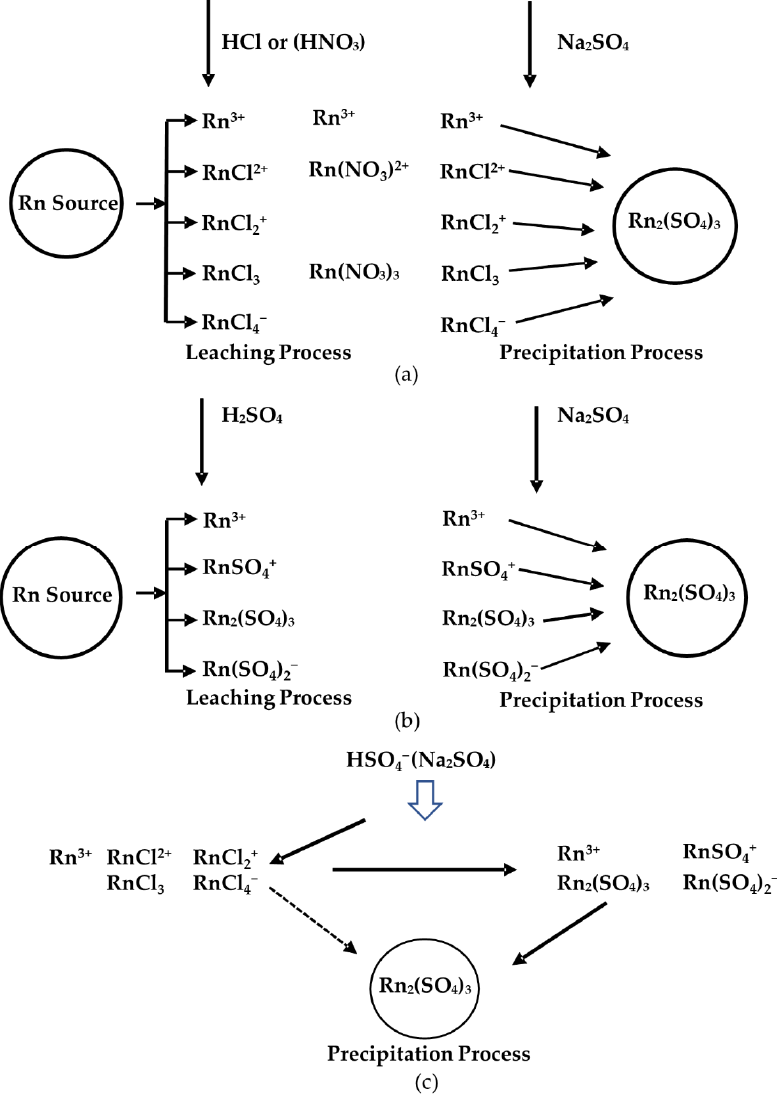
Figure 1. Schematics showing leaching process and precipitation process of ( a ) HCl or HNO 3 system; ( b ) H 2 SO 4 system; and ( c ) conversion of Rn-Cl complexes to the Rn-SO 4 complexes and their precipitation.